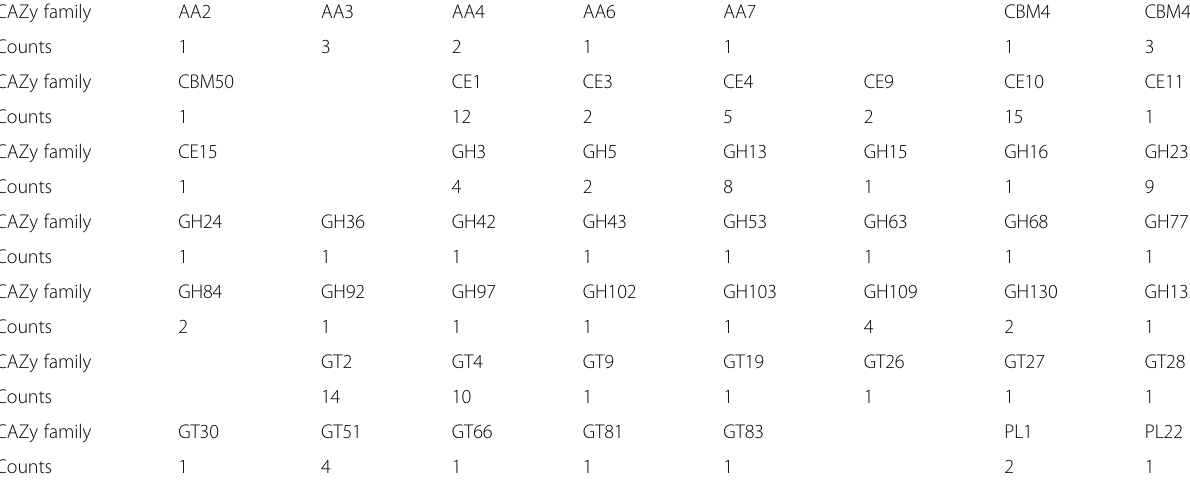
Table 5 CAZyme profile of A. paucihalophilus TH1 – 2 T CAZy family